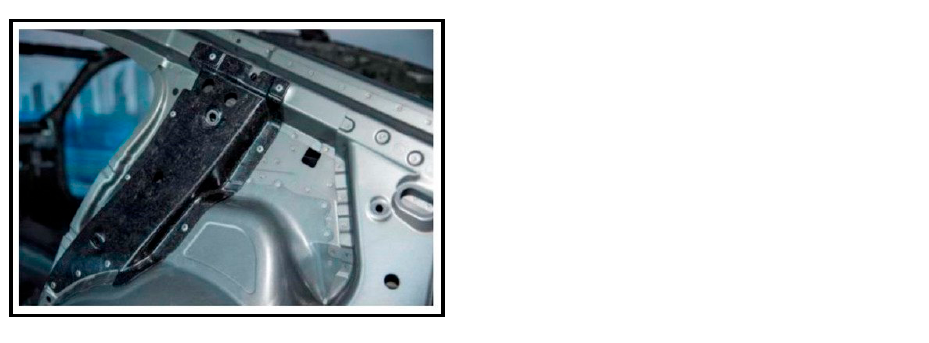
Figure 6. C-pillar from sheet molding compound (SMC, within BMW 7 series), reproduced from [157].